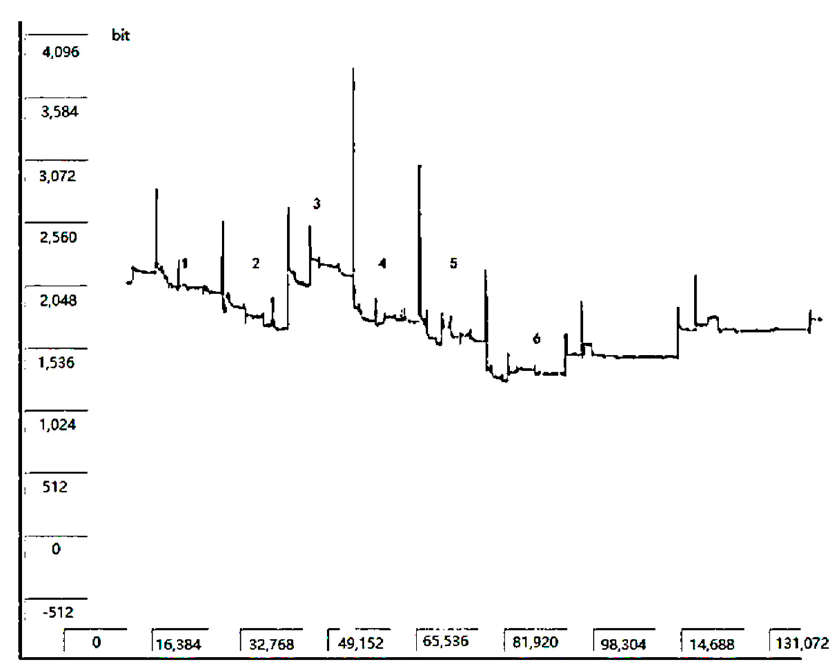
Figure 22. The Gatling bolt acceleration under the sampling frequency of 200 kHz. Note: 1—graduated arc, 2—main roller axis, 3—working part axis, 4—mechanism carriage axis, 5—graduated arc, 6—box mechanism axis.